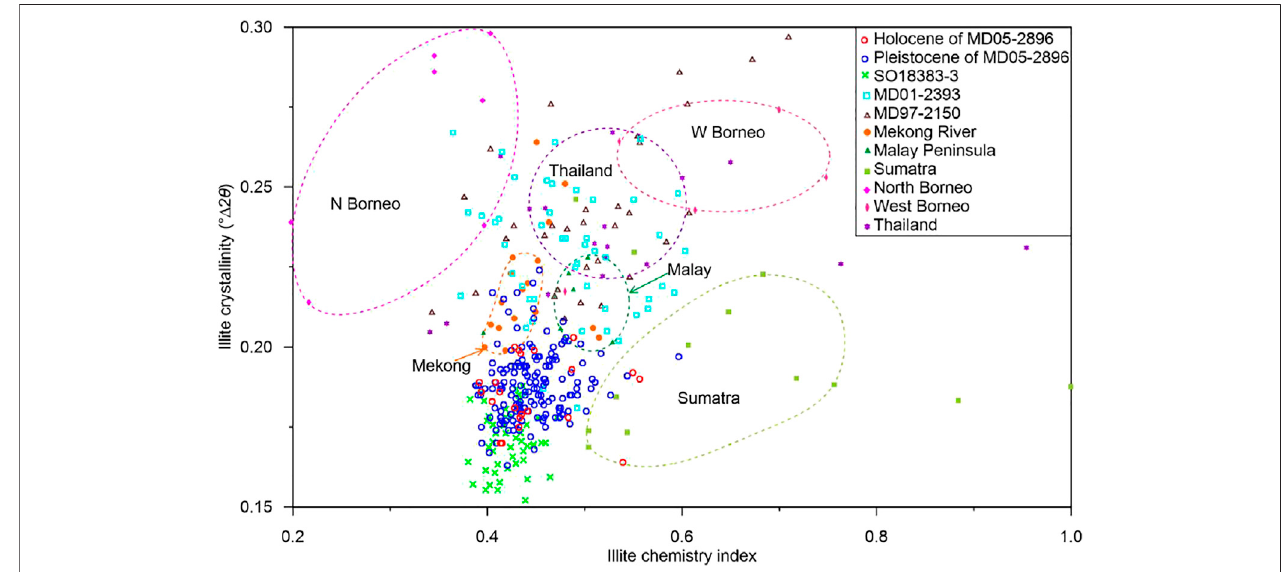
FIGURE 6 | Correlation plot of illite chemistry index and illite crystallinity. The sediment samples of Core MD05-2896 are distinguished between the Holocene and the Pleistocene. Surrounding river samples in the Mekong River, Borneo, Sumatra, the Malay Peninsula, and Thailand for potential sediment sources (Liu et al., 2007a; Liu et al., 2012; Liu et al., 2016) and sediment samples at referred Cores MD01-2393, MD97-2150, and SO18383-3 (Liu et al., 2004; Jiwarungrueangkul et al., 2019b) are plotted for comparison.